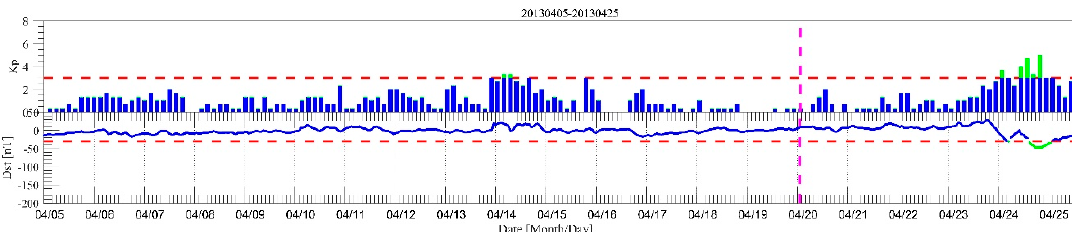
Figure 8. The Kp and Dst index during 5–25 April 2013; the green histogram and curve indicate high geomagnetic activities and space weather activities, and the pink dashed line denotes the actual time of the Lushan earthquake.